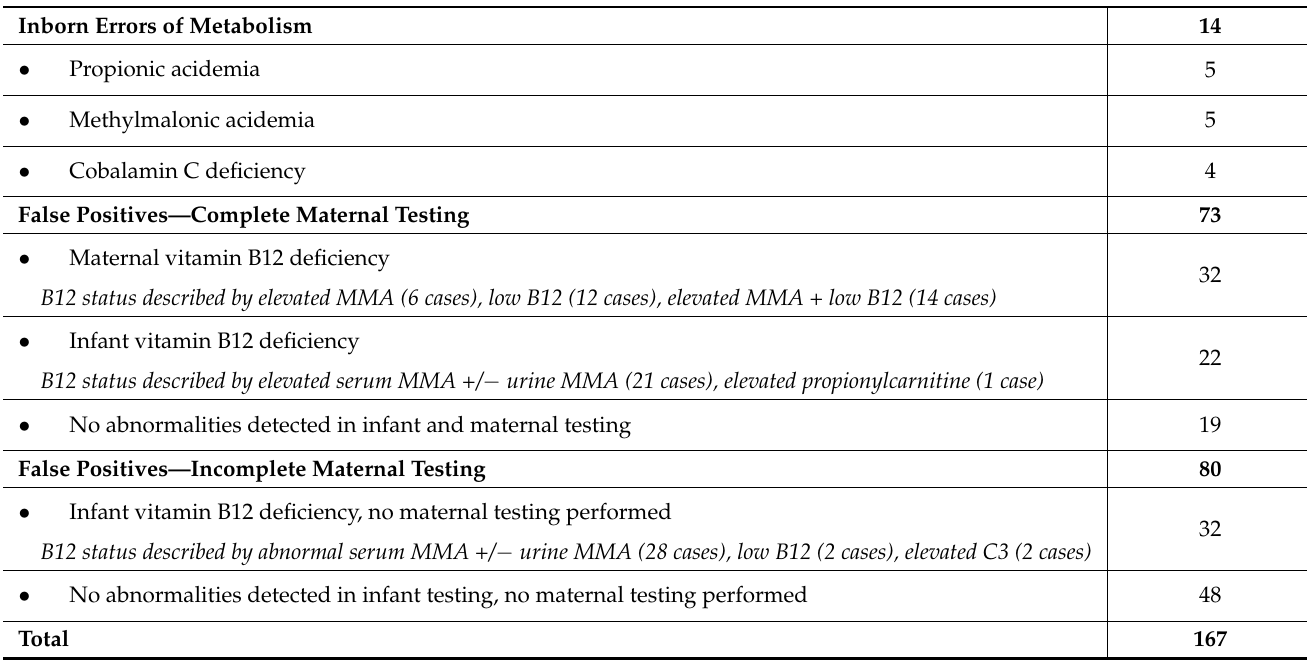
Table 1. Diagnoses from evaluation of positive propionylcarnitine (C3) newborn screens in Wisconsin from 2013 to